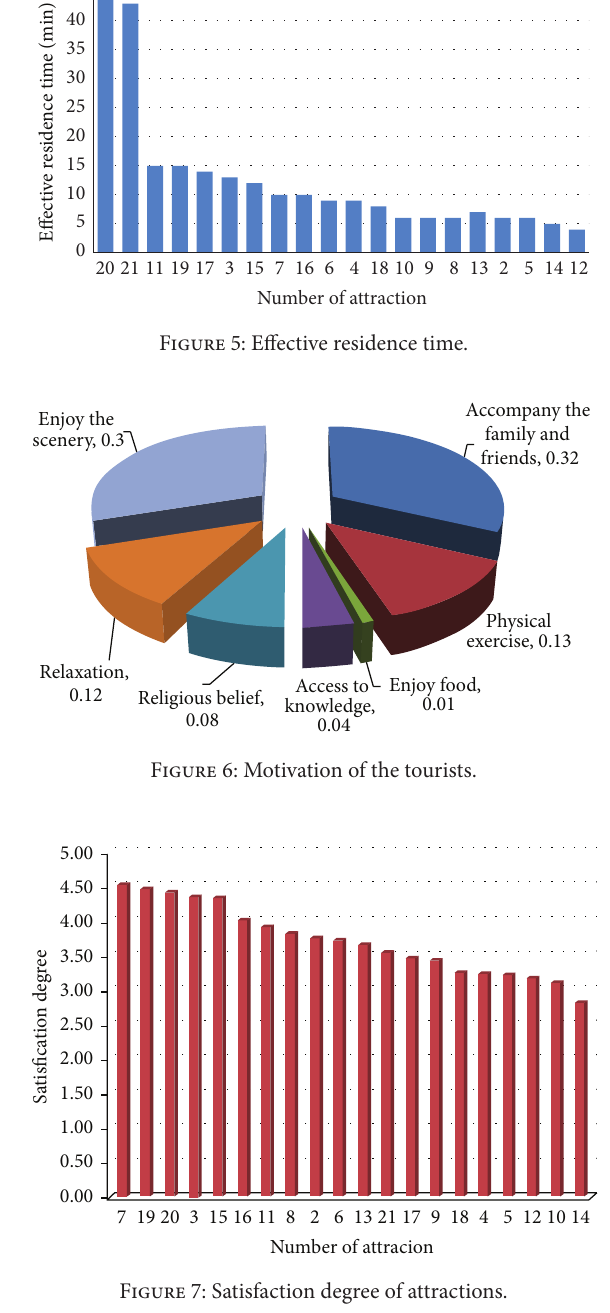
Figure 7: Satisfaction degree of